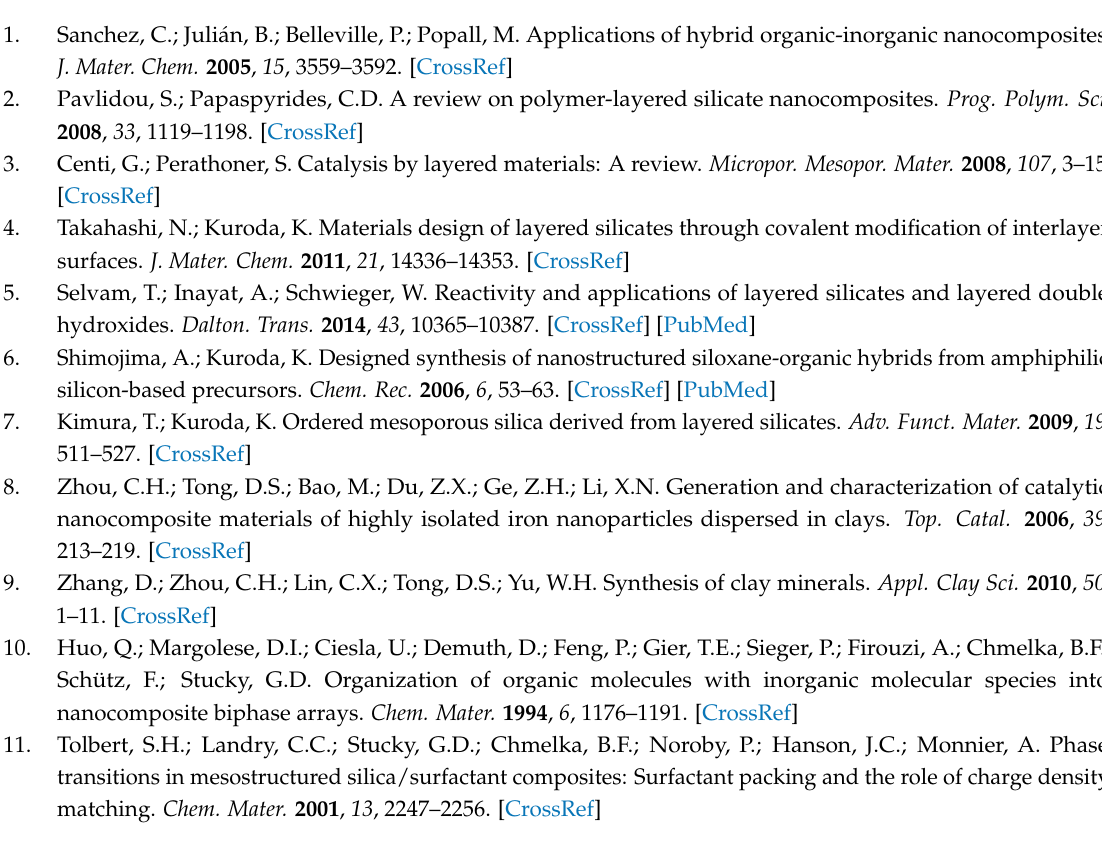
Figure S1: XRD patterns for UVM-Ln solids, Figure S2: TGA curves for samples UVM-Ln, Figure S3: DTA curves for samples UVM-Ln, Figure S4: representative SEM image of UVM-Ln solids, Figure S5: Low-angle XRD pattern of the organically modified Epoxy-UVM-L12 sample, Figure S6: TEM image of the delaminated UVM-L16 sample, Figure S7: AFM images of the delaminated UVM-L16